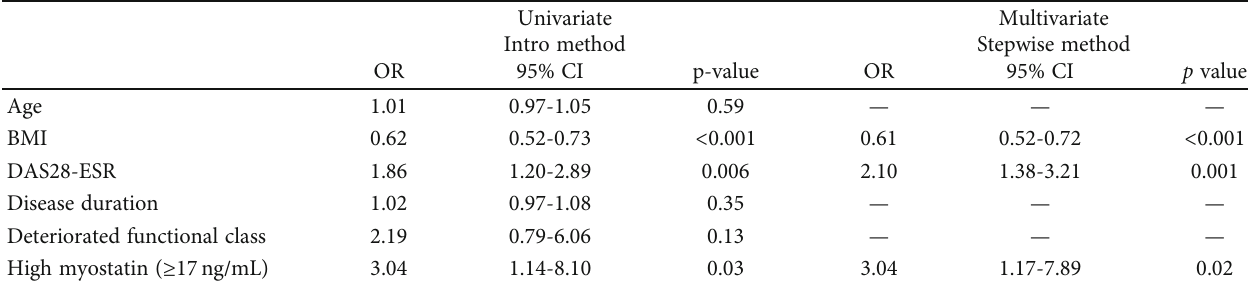
Table 5: Associated factors with low muscle mass in